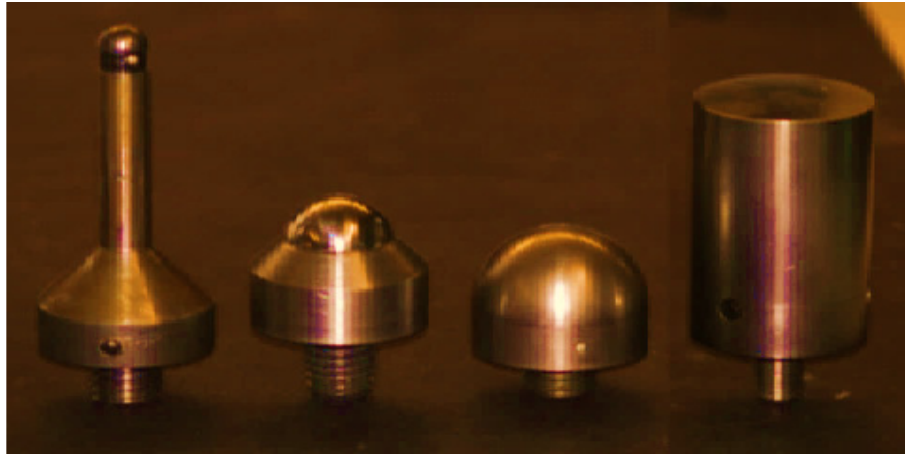
Figure 3. Indentation, different sizes of punch are used, which are hemispherical punches of diam- eters 12 mm, 28 mm, and 44 mm, and a flat cylindrical punch of 25 mm.